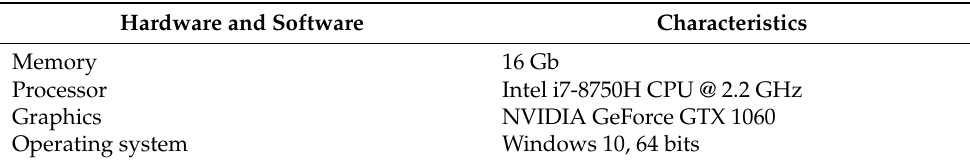
Table 3. Machine